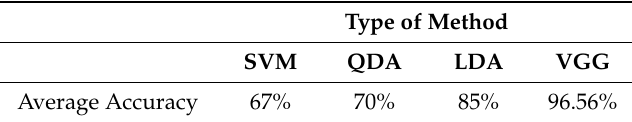
Figure 17. Detailed results and comparison of VGG with other methods: ( a ) support vector machine (SVM); ( b ) quadrature discernment analysis (QDA); ( c ) linear discernment analysis (LDA); and ( d ) VGG-16. Table 4. Comparison of the accuracy with other techniques.